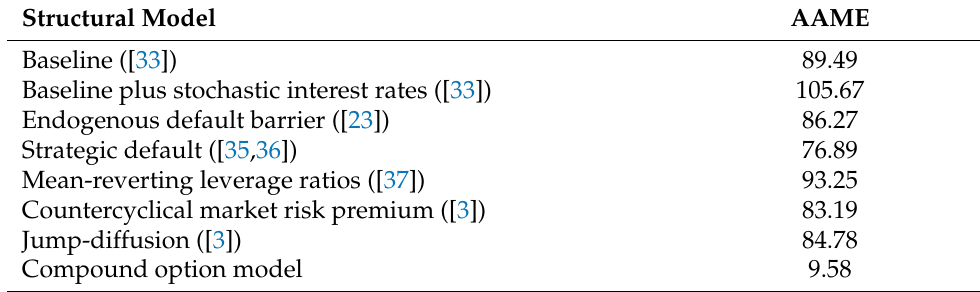
Table 9. Average absolute mean errors (expressed in basis points) based on the results in [3]. There, the authors analyze the ability of structural models of default to reproduce observed credit spreads. They test a simple baseline model with and without stochastic interest rates ([33]), a model